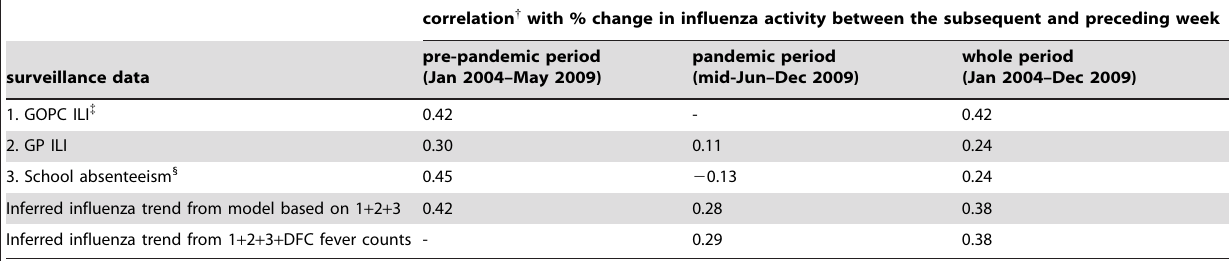
Table 2. Comparison of inferred trend from individual surveillance data and from model based on GOPC ILI rate, GP ILI rate and school absenteeism rate with changes in influenza activity *